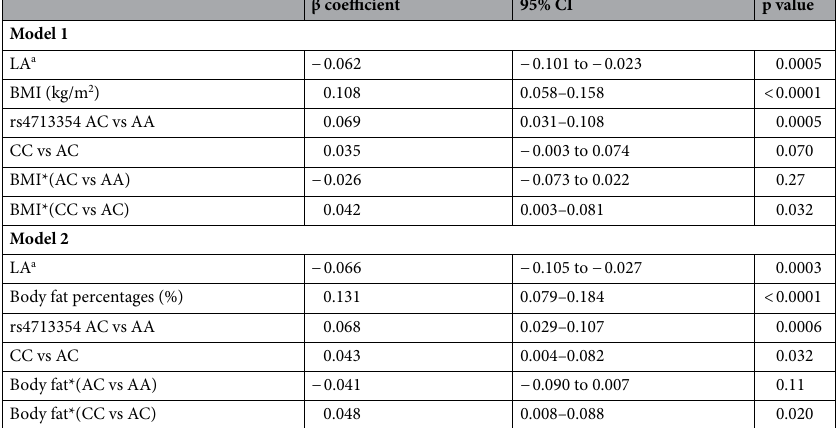
Table 4. Multivariate analysis in never-smokers for elevated blood eosinophil counts including LA, BMI or body fat, rs4713354, and its interactions as variables. LA linoleic acid, BMI body mass index, β coefficient standardized partial regression coefficient, CI confidence interval. a Log-transformed. Adjusted by age, sex, elapsed time after a meal, medication for dyslipidemia, serum HDL cholesterol, serum triglycerides, serum total IgE and high-sensitivity CRP.